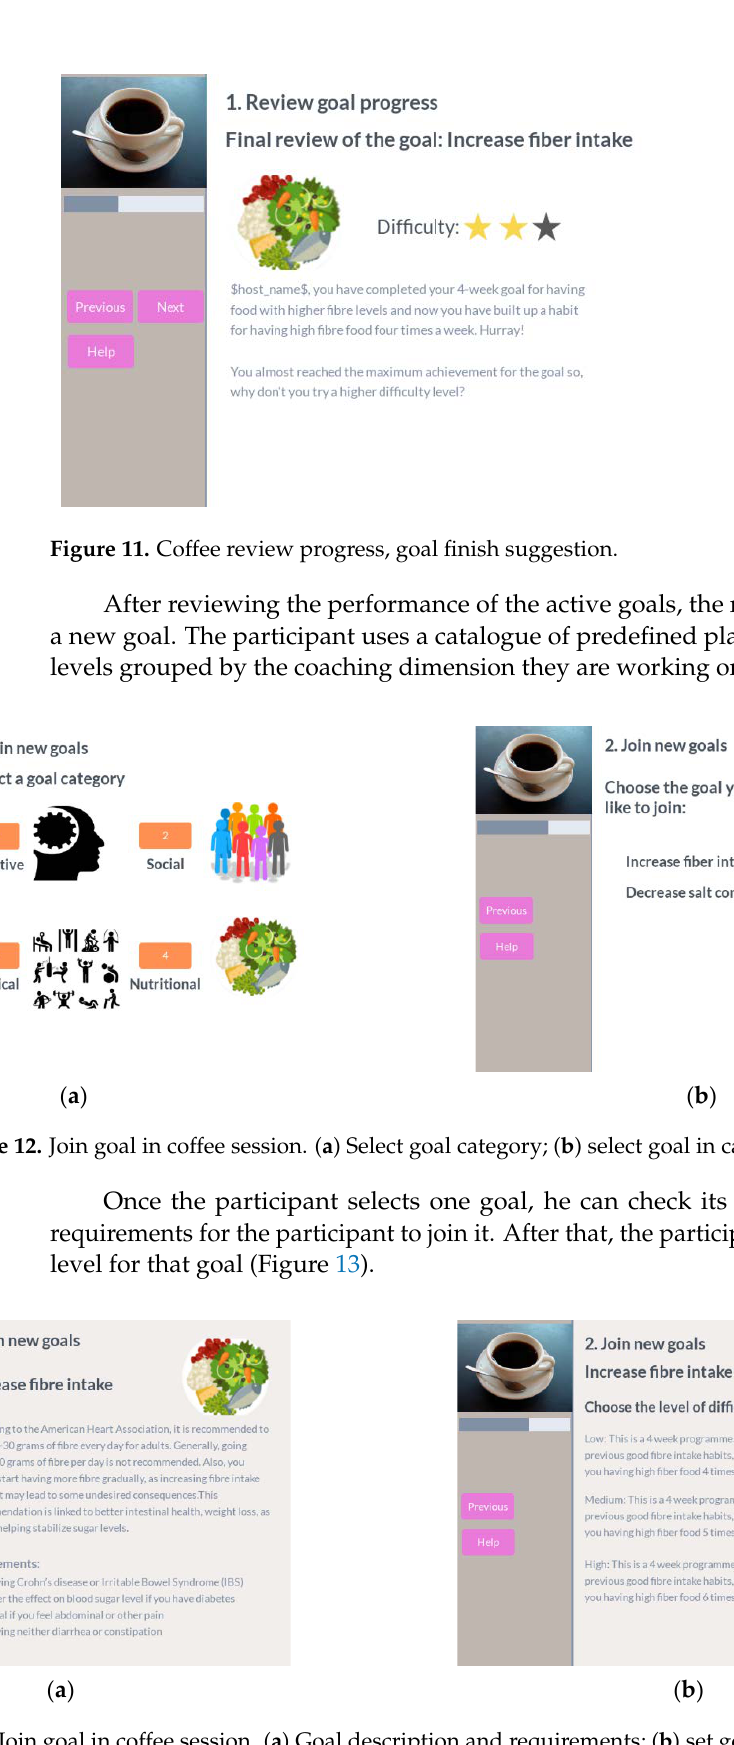
Figure 10. Coffee review progress, overall performance.